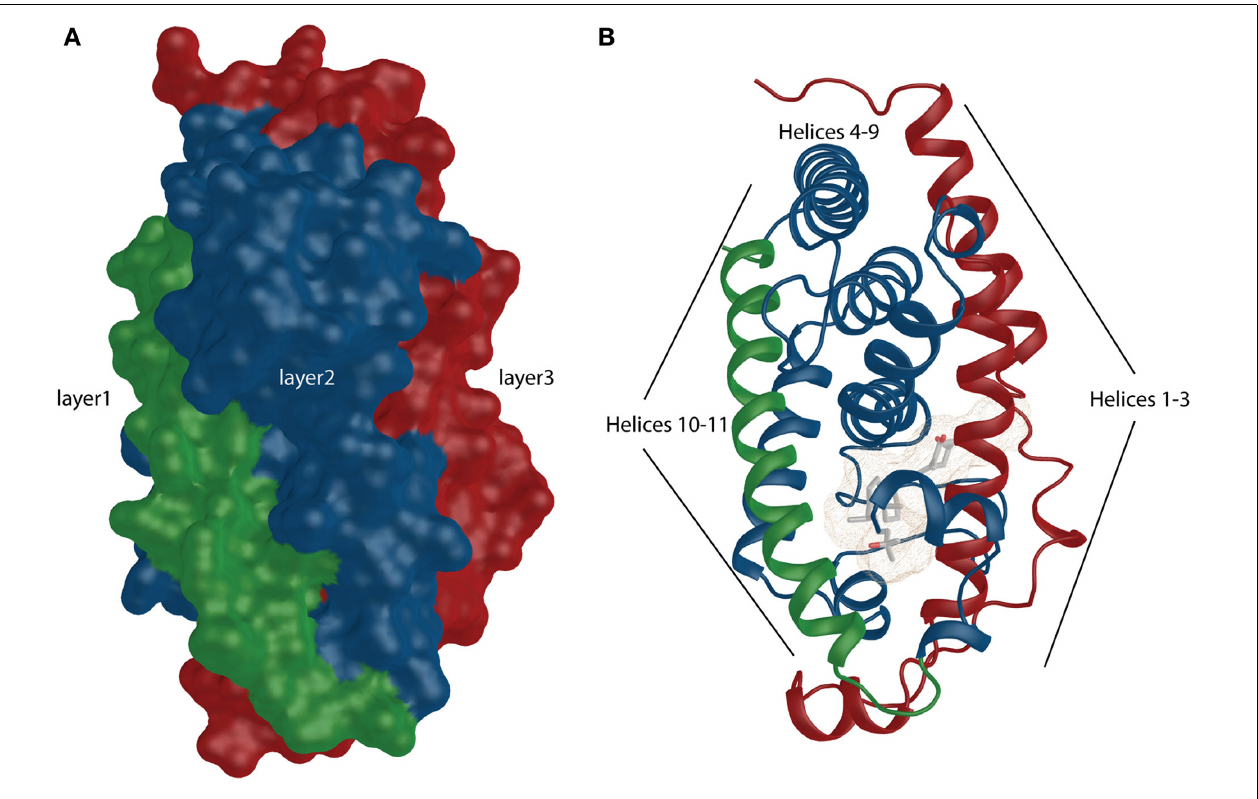
highlighted in green, blue and red. (B) Numbered helices belonging to different layers are shown and they are highlighted similarly as in surface